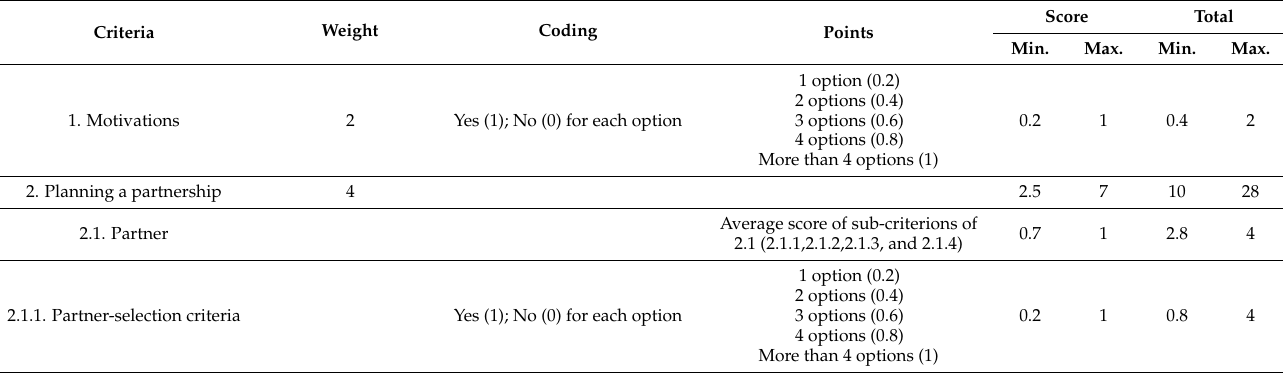
Table A1. Weighted scoring model for examining strength of the